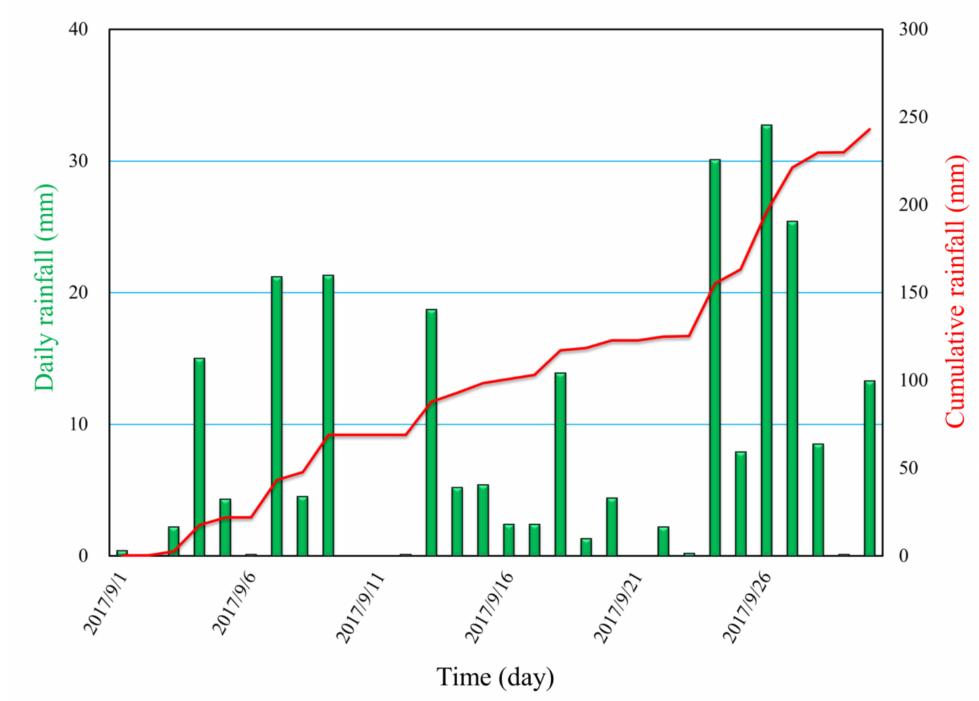
Figure 4. Rainfall distribution in September 2017 recorded by the Zechawa precipitation